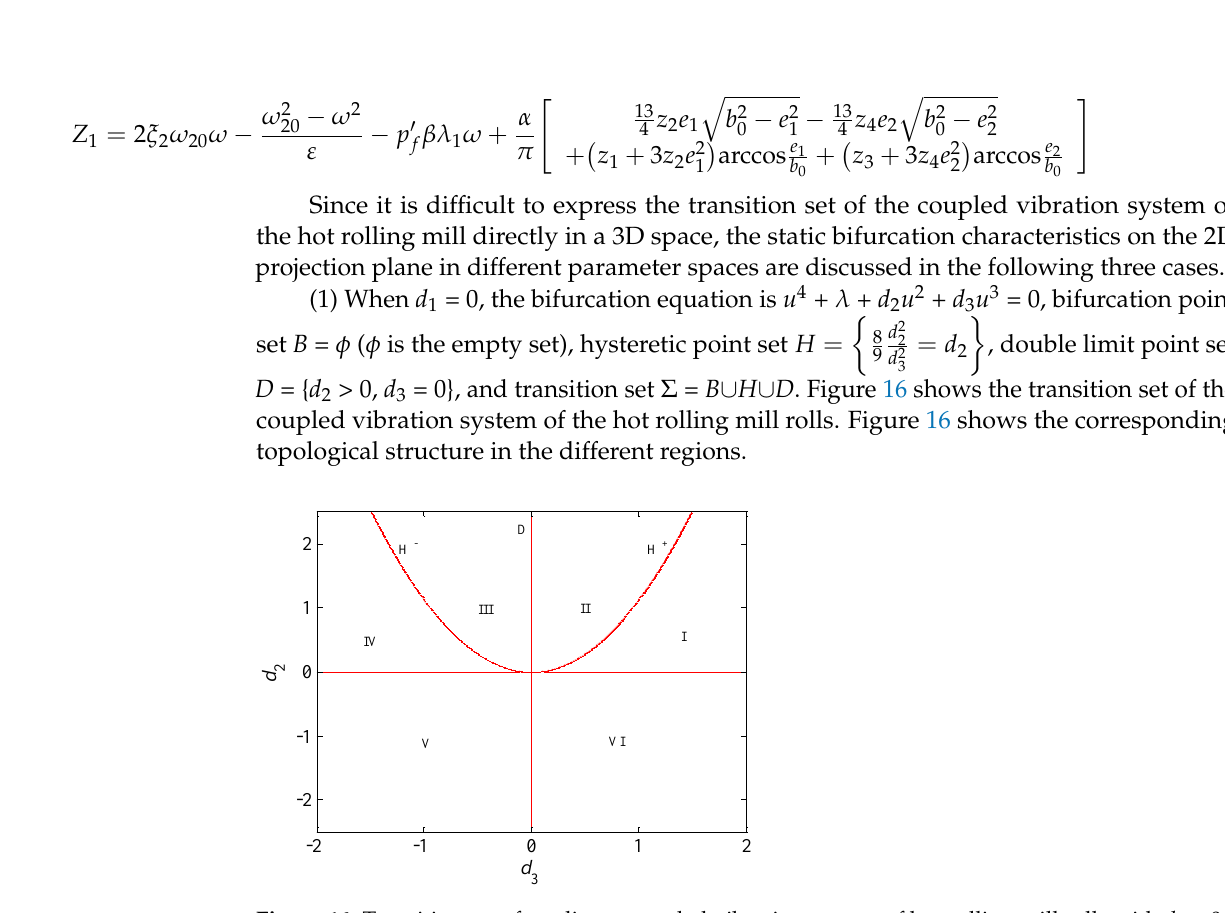
Figure 16. Transition set of nonlinear coupled vibration system of hot rolling mill rolls with d 1 = 0.